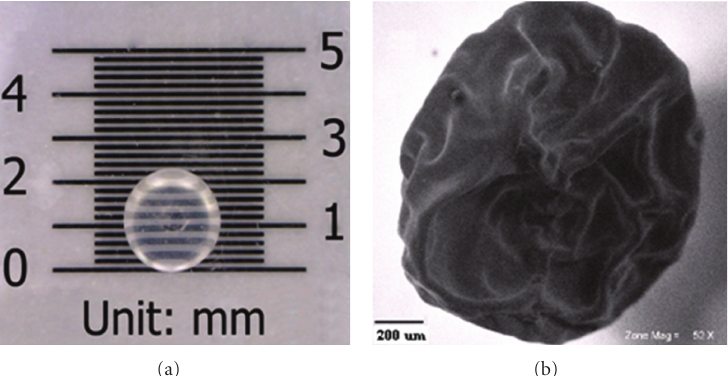
Figure 1: Optical image (a) and SEM of the prepared gelatin-alginate bead (b).